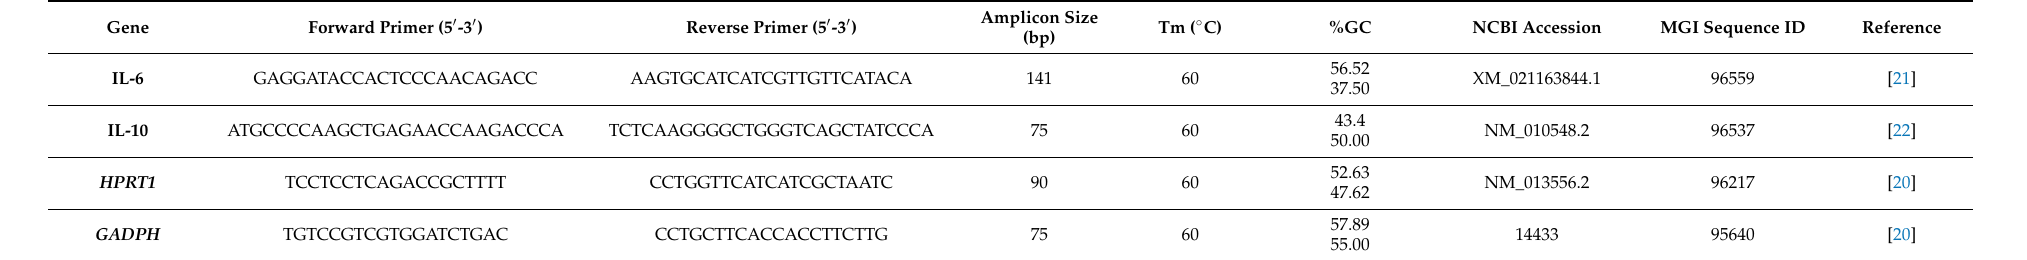
Table 3. Summary of reference and target genes used during the